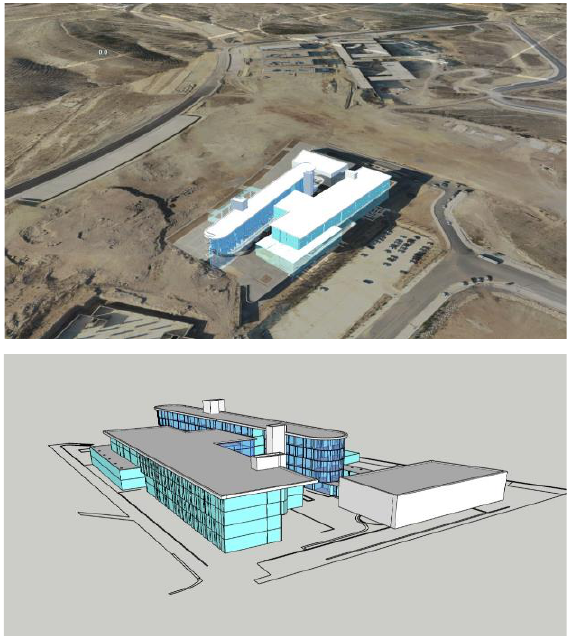
Figure 8/a. SBIF 3D Model with Orthophoto, Figure 8/b. SBIF 3D Model.